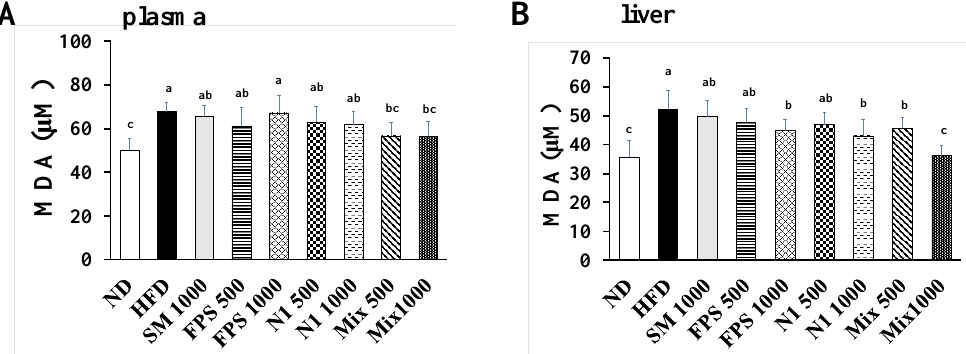
Figure 4. The levels of malondialdehyde (MDA) in the ( A ) plasma and ( B ) liver of rats fed with various fermented SBM products. The rats were fed an HFD for 10 weeks, followed by various fermented SBM products for 6 weeks. After sacrifice, the rats’ blood and liver samples were individually isolated. The concentration of MDA in the plasma and liver homogenates was determined. Results are expressed as a mean ± standard deviation for each group of rats ( n = 8). Different letters (a–c) indicate the statistical difference ( p < 0.05) between each group.